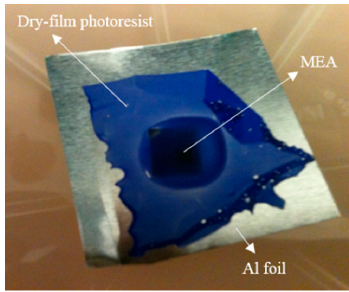
Figure 4. Optical image of masking process using dry-film photoresist as a mask.